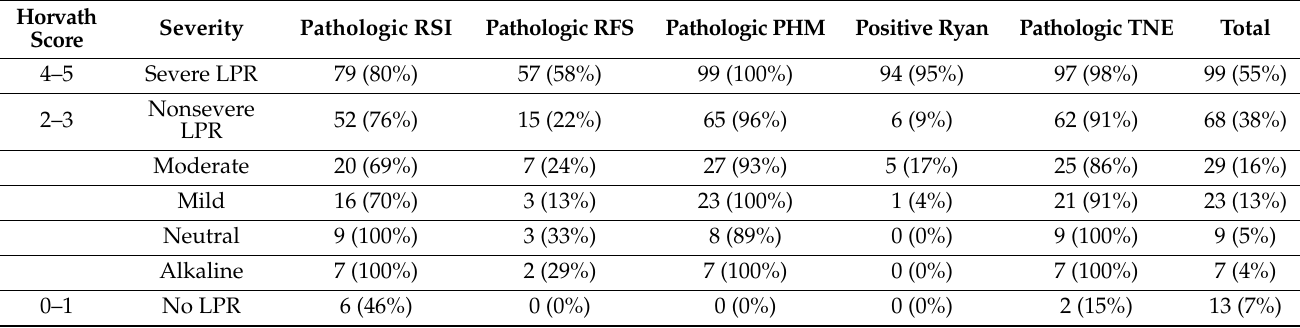
Table 1. Study results for each method in detecting laryngopharyngeal reflux according to the Horvath Score ( n = 180). Horvath